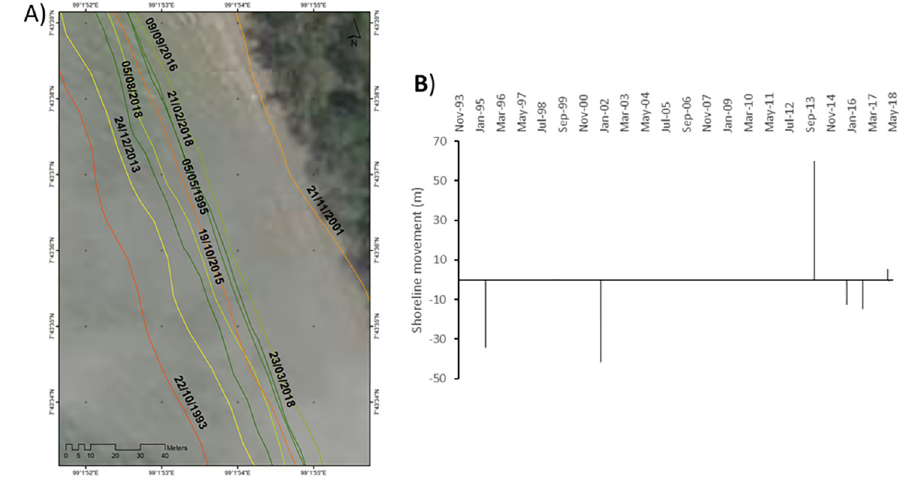
Fig 9. Representations of the shoreline movements observed during the survey period in site 4. A) Visualisation of the shoreline positions for the highest water level marks digitised with CoastSat. B) Shoreline movements measured using DSAS between two consecutives chronologically ordered digitised shorelines; negative values correspond to erosion and positive values to accretion. Basemap satellite images accessed from World Imagery ESRI Tile Layer. Credits: Esri, Maxar, GeoEye, Earthstar Geographics, CNES/Airbus DS, USDA, USGS, AeroGRID, IGN, and the GIS User